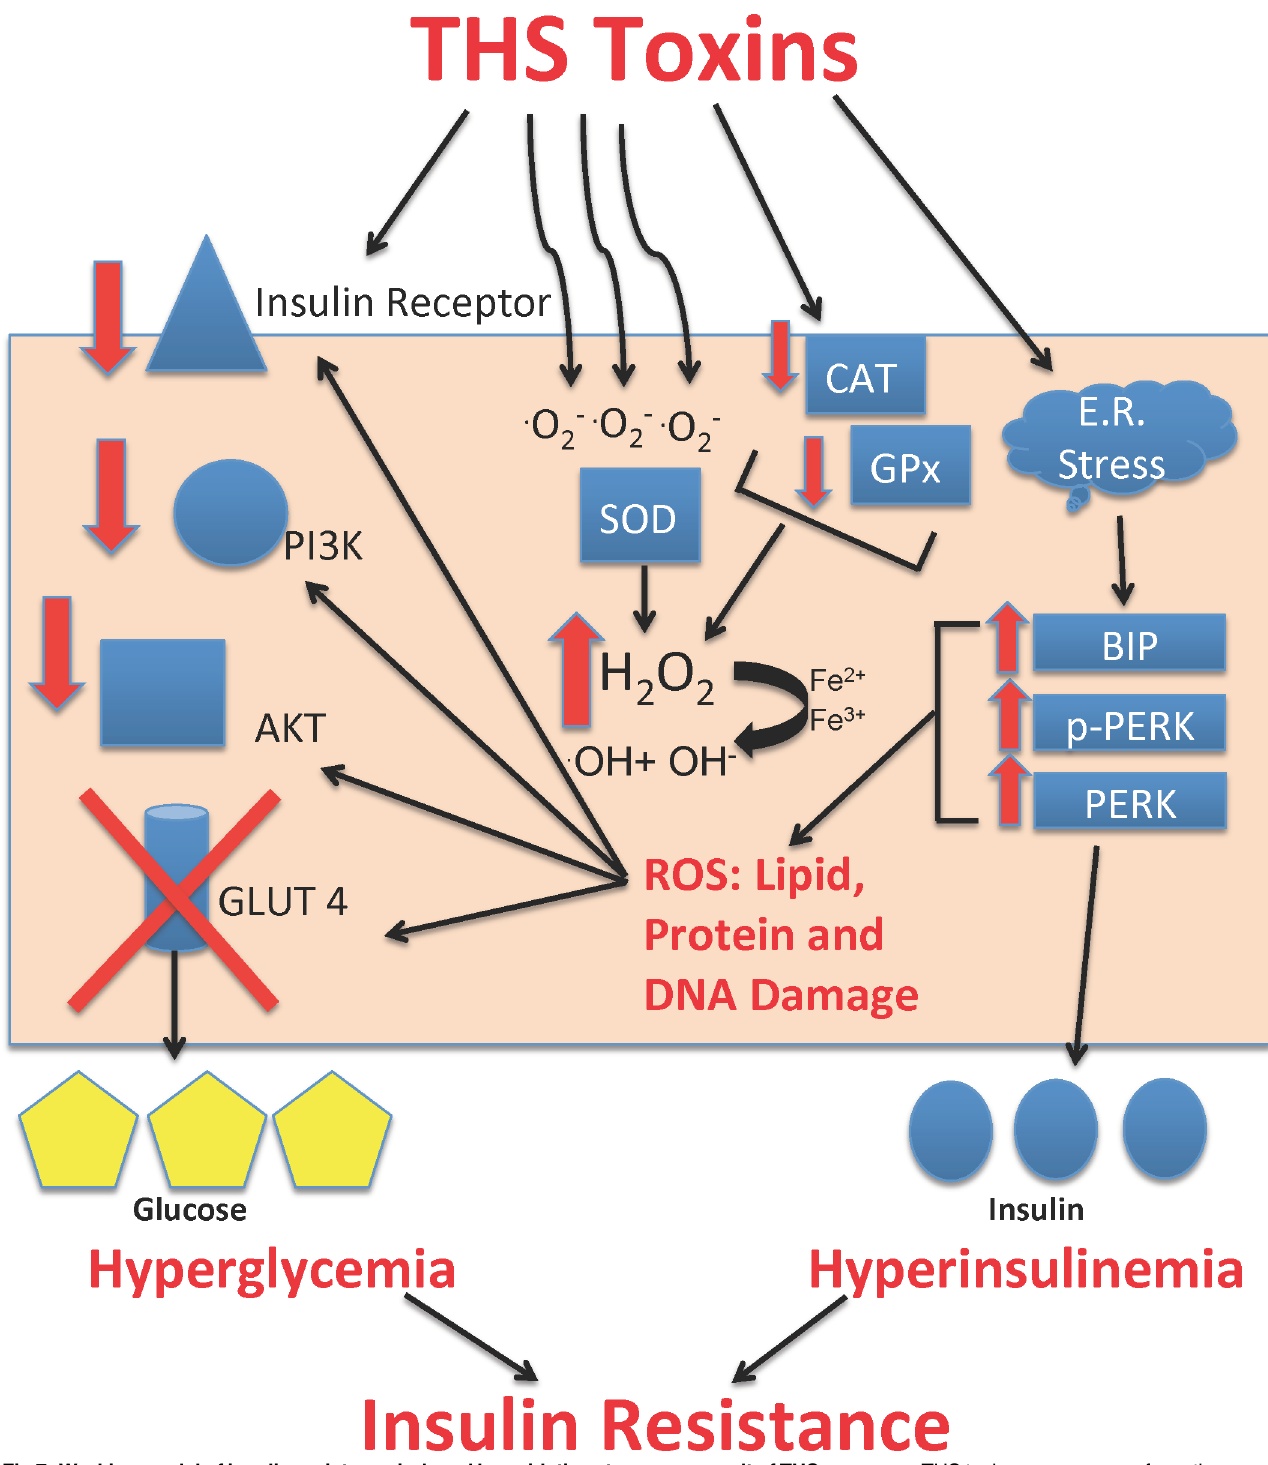
Fig 7. Working model of insulin resistance induced by oxidative stress as a result of THS exposure. THS toxins are a source of reactive oxygen species. These oxidants can decrease the expression and activity of insulin-signaling molecules such as IR and its downstream signaling molecules PI3k and, AKT ultimately leading to the inability of GLUT 4-containing vesicles to fuse with the plasma membrane. In response to excessive levels of the superoxide anion (O 2.- ), SOD is activated and dismutates O 2.- radicals into hydrogen peroxide. THS toxins, however, reduce the activity of catalase, preventing the conversion of H 2 O 2 into water and O 2 . As hydrogen peroxide accumulates in the cell, it undergoes tertiary reactions with iron resulting in the